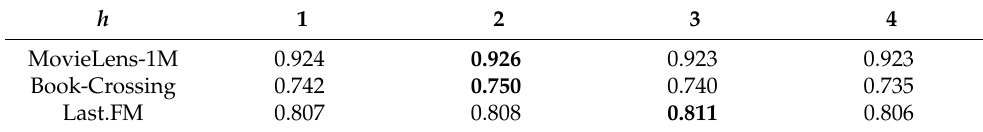
Table 5. Results of AUC on three datasets with different item perception depths.